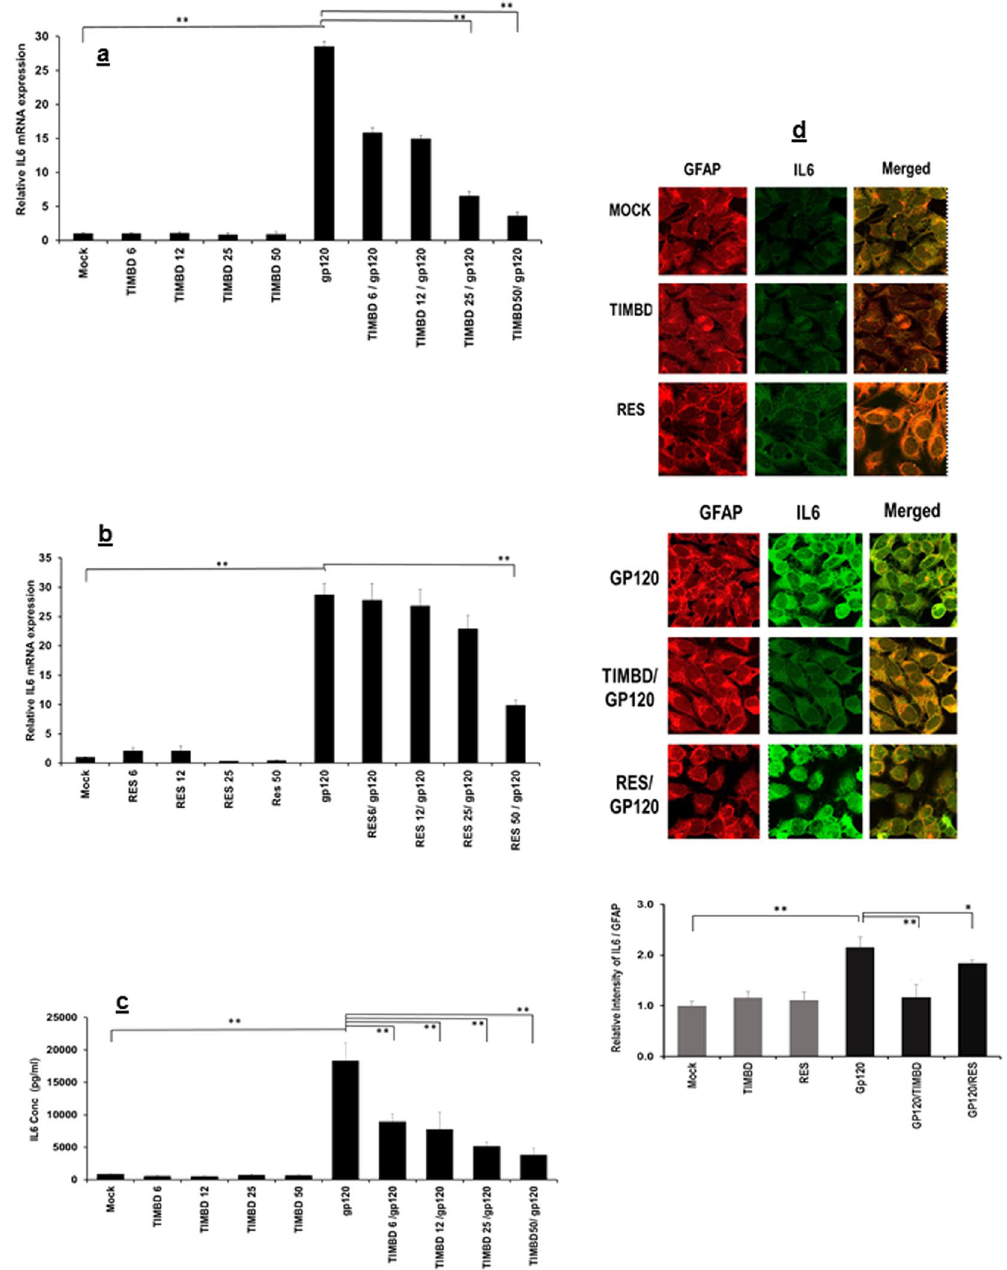
Figure 1. TIMBD and not RES suppresses IL6 mRNA and protein expression levels in a dose dependent manner. SVG astrocytes were treated with 6 to 50 µ M TIMBD ( a ) or RES ( b ) 1 h prior to transfection and then transiently transfected with plasmid encoding HIV-1 gp120 for 5 h. The cells were harvested at 6 h and the expression levels of IL6 mRNA were determined by RT-PCR ( a and b ). ( c ) IL6 protein concentrations in the supernatant were measured at 48 h post-transfection by multiplex cytokine assay. ( d ) Expression levels of IL-6 and GFAP proteins were assayed by immunocytochemical methods and analyzed using confocal microscopy. The methods for Fig. 1a to d are described in the materials and methods section. The intensity of IL6/GFAP ( d ) was calculated using imageJ software. Each bar represents mean ± SE for at least 3 independent experiments, with each experiment done in triplicate. One-way Anova was used for statistical analysis and statistical significance is denoted as * (p-value ≤ 0.05) and ** (p-value ≤